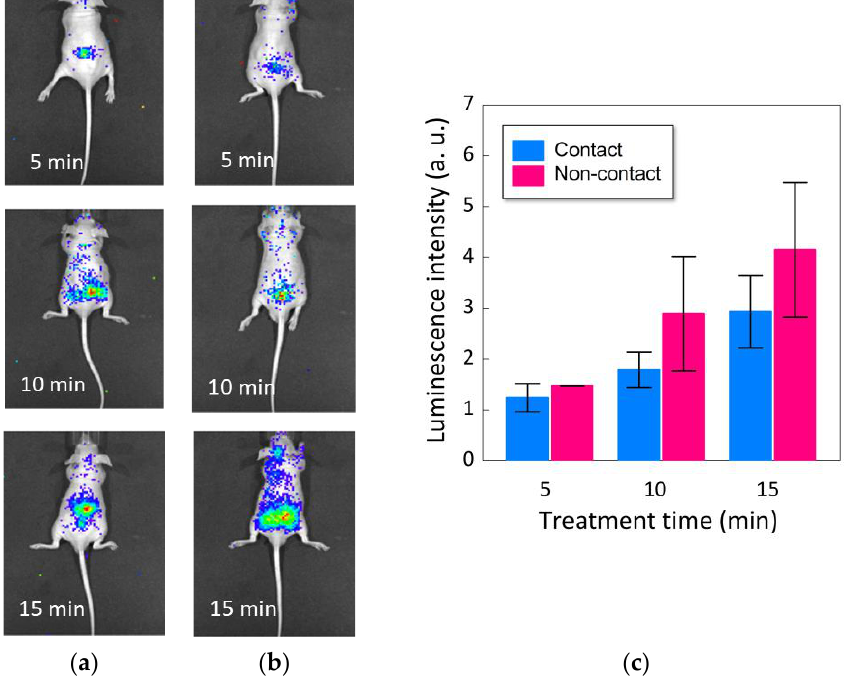
Figure 10. In vivo detection of ROS (luminescence resulting from reaction of luminol with ROS) following ( a ) contact and ( b ) non-contact plasma treatments. The averaged luminescence intensity counts (from n = 5 mice) are plotted in ( c ).